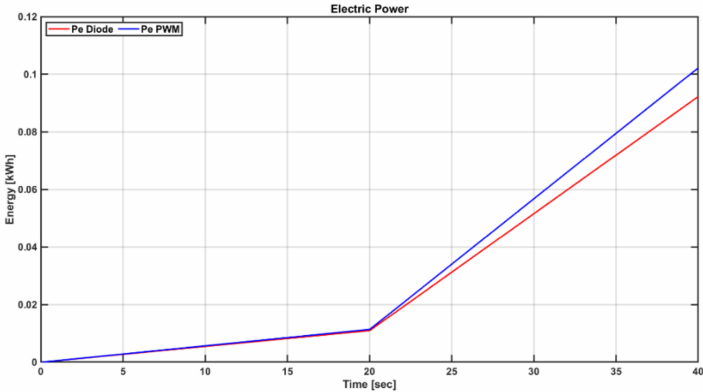
Figure 13. Comparison of output energy of PTO system in integrated simulation at constant input flow velocity from 14 m / s to 28 m /